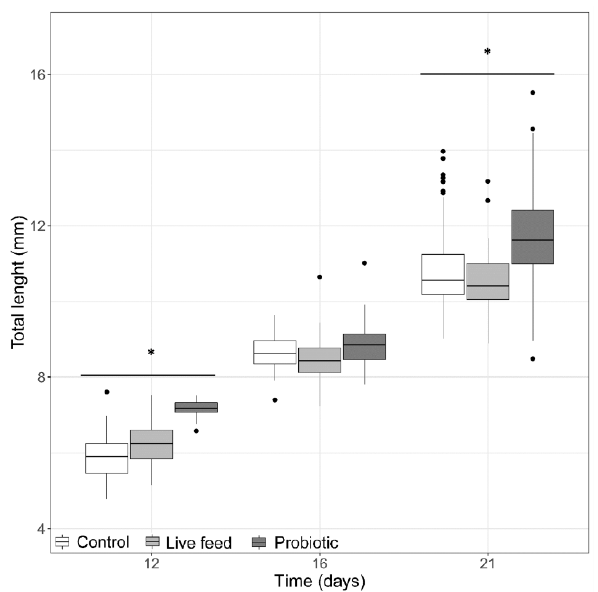
Figure 1. Larval total length from three treatments at days 12 ( n = 40), 16 ( n = 40), and 21 dph ( n = 100). Dots shown are the out layers, whiskers indicate the maximum and minimum values excluding out layers, the line in the middle of box is the median value and upper and lower quartiles are the ends of the box. Statistically significant differences between treatments are marked with an asterisk.